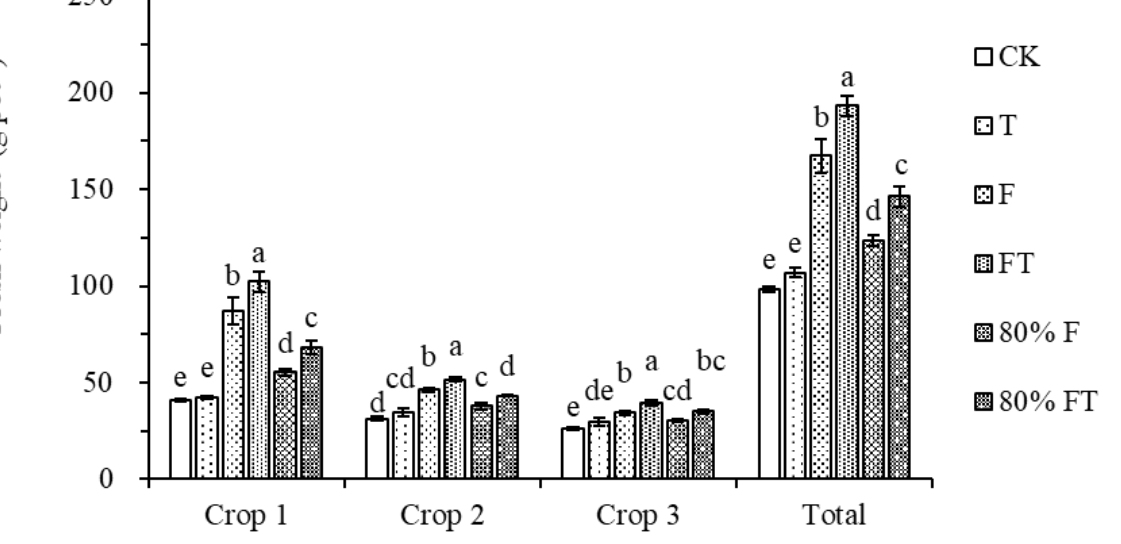
Figure 1. Effect of the preparation on pakchoi fresh weight. Values were expressed as means (n = 4) ± SE. Different letters within the same crop indicate significance at the 5% level.